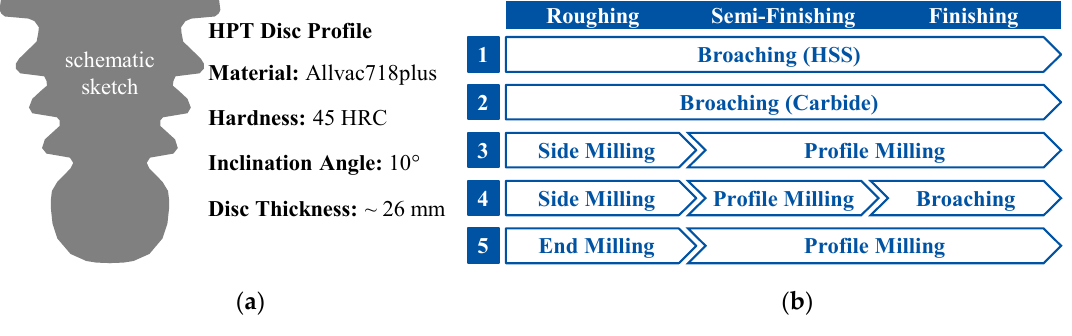
Figure 1. Profile and key characteristics ( a ), assessed process chains ( b ).